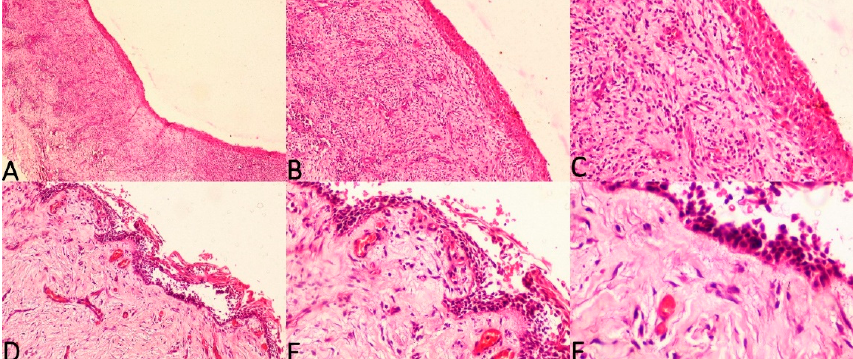
Figure 3. Photomicrographs of haematoxylin and eosin stain. Unicystic ameloblastoma—intraluminal type with absence of SEH, ( A ) 40×, ( B ) 100× and ( C ) 200×. Unicystic ameloblastoma—intraluminal type with prominent SEH, ( D ) 100×, ( E ) 200× and ( F ) 400×.